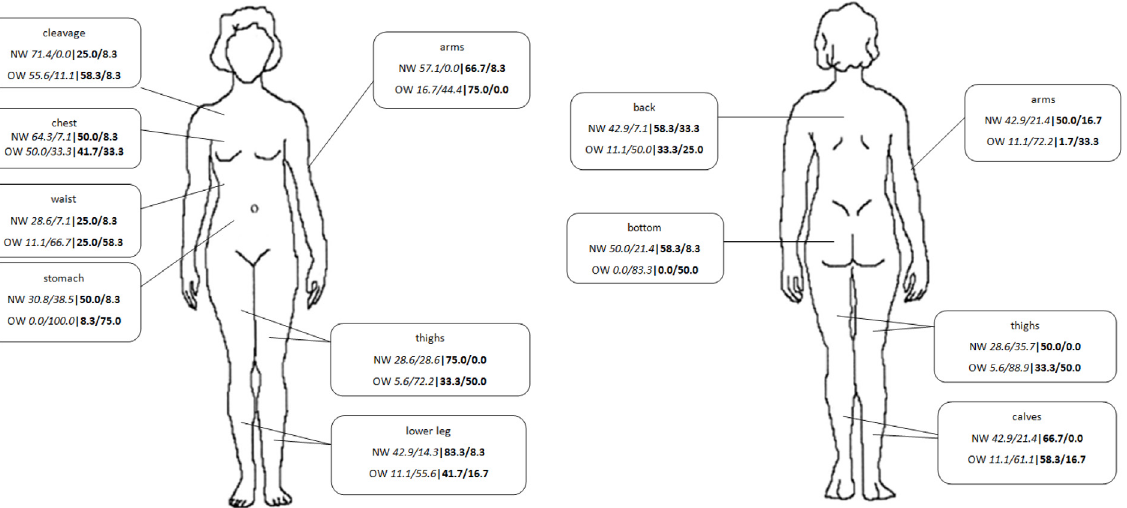
Fig 1. Results for the percentage of attractiveness ratings for all regions of interest (ROIs). Allocation on the basis of weight status (normal weight (NW) vs. overweight (OW)), gender (female: italics vs. male: bold) and attractiveness (attractive/